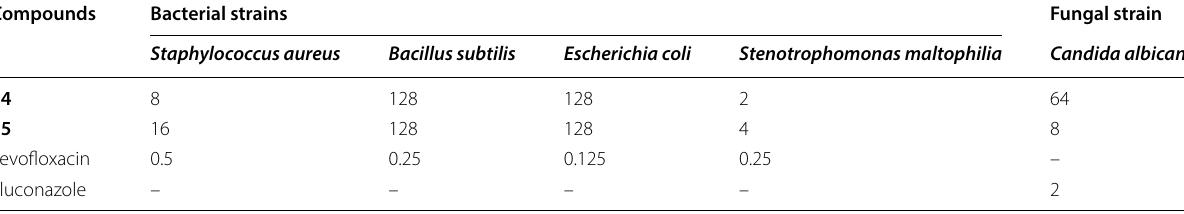
µg/ml) of compounds a4 and a5 =